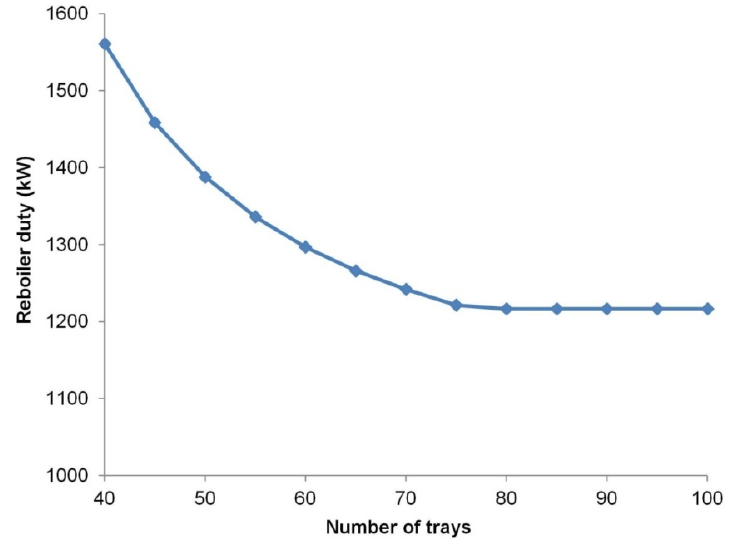
Figure 4. Sensitivity analysis between the number of stages and the reboiler duty for the molten salt extractive distillation column.